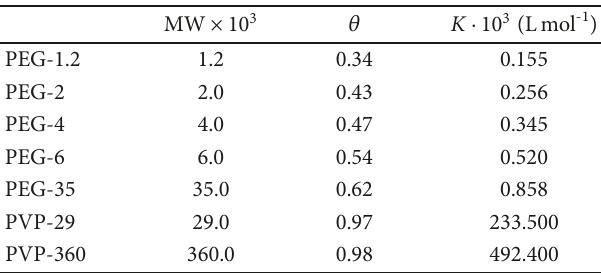
Figure 2: Scheme of the equilibrium reactions involved in the complexation reaction between PAA and PVP. Table 1: Degree of linkage ( θ ) and stability constants ( K ) of PAA-PEG and PAA-PVP complexes at 30 °